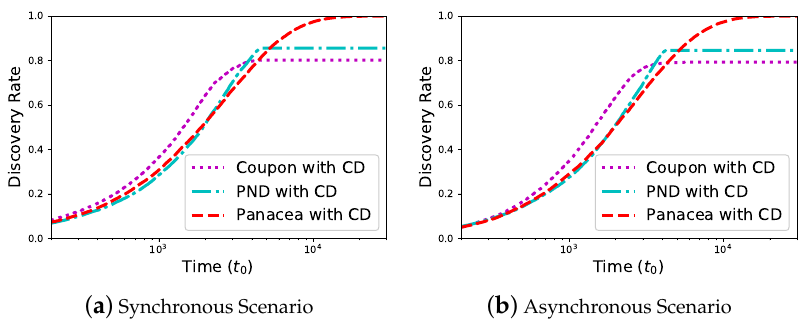
Figure 6. Panacea-WCD achieves higher discovery rate with